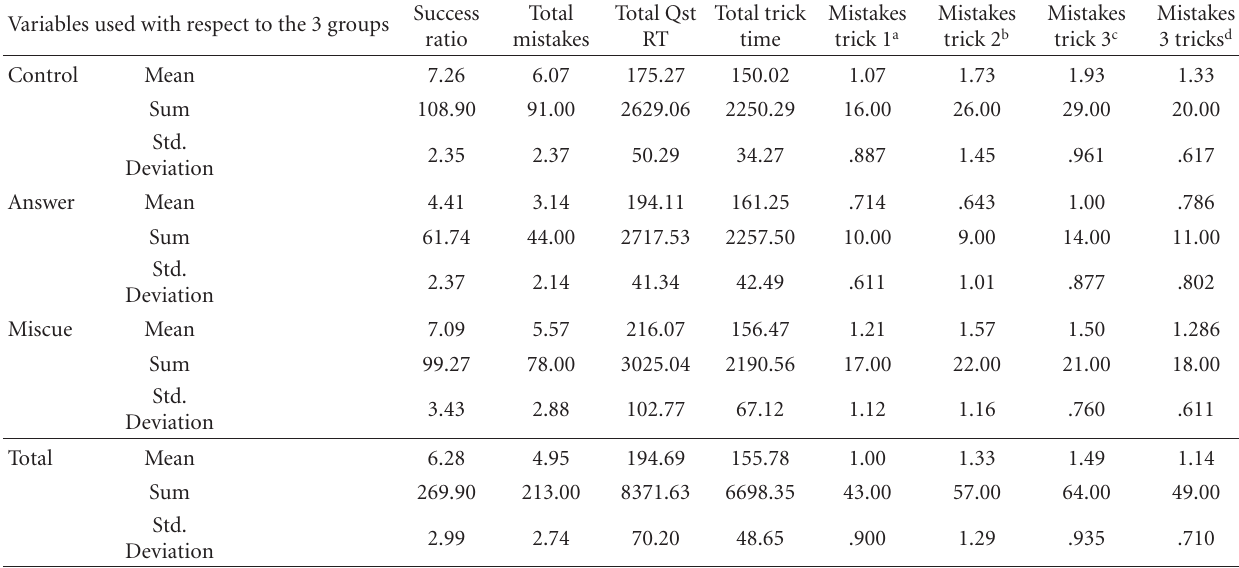
Variables used with respect to the 3 groups